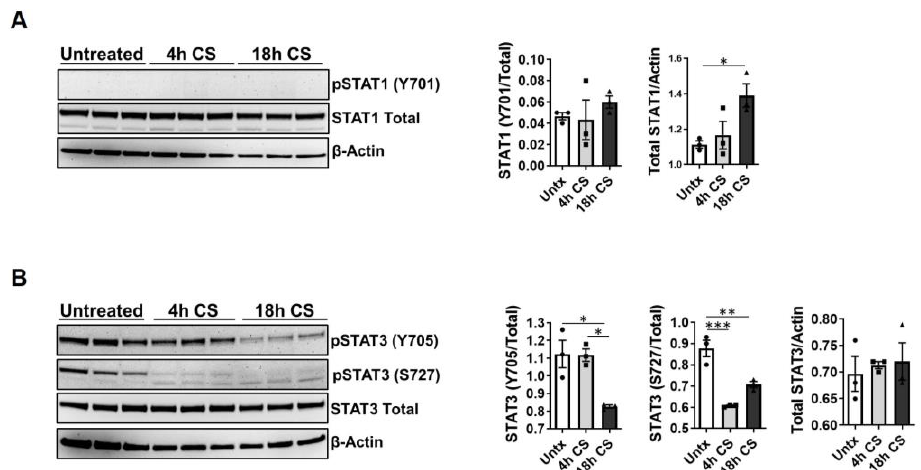
Figure 2. Cold storage decreases phosphorylated STAT3 in donor kidneys. Three experimental groups were considered: Untreated control, 4 h CS, and 18 h CS; in CS groups, kidneys were isolated, flushed, and stored in University of Wisconsin CS solution for the indicated time; ( A , B ) Renal extracts (30 μ g) were prepared using RIPA and assayed via SDS-PAGE Western blot (representative blots are shown) as previously: ( A ) Y701-phosphorylated/total STAT1, ( B ) Y705- and S727-phosphorylated/total STAT3. Data are the mean ± SEM (bars, n = 3). Differences between group means were compared with 1-way ANOVA followed by Brown–Forsythe and Welch’s corrections for multiple group comparisons; p < 0.05 was considered significant. *, p < 0.05; **, p < 0.01, ***, p < 0.001. Each solid circle, square, or triangle represent individual animals within the group.